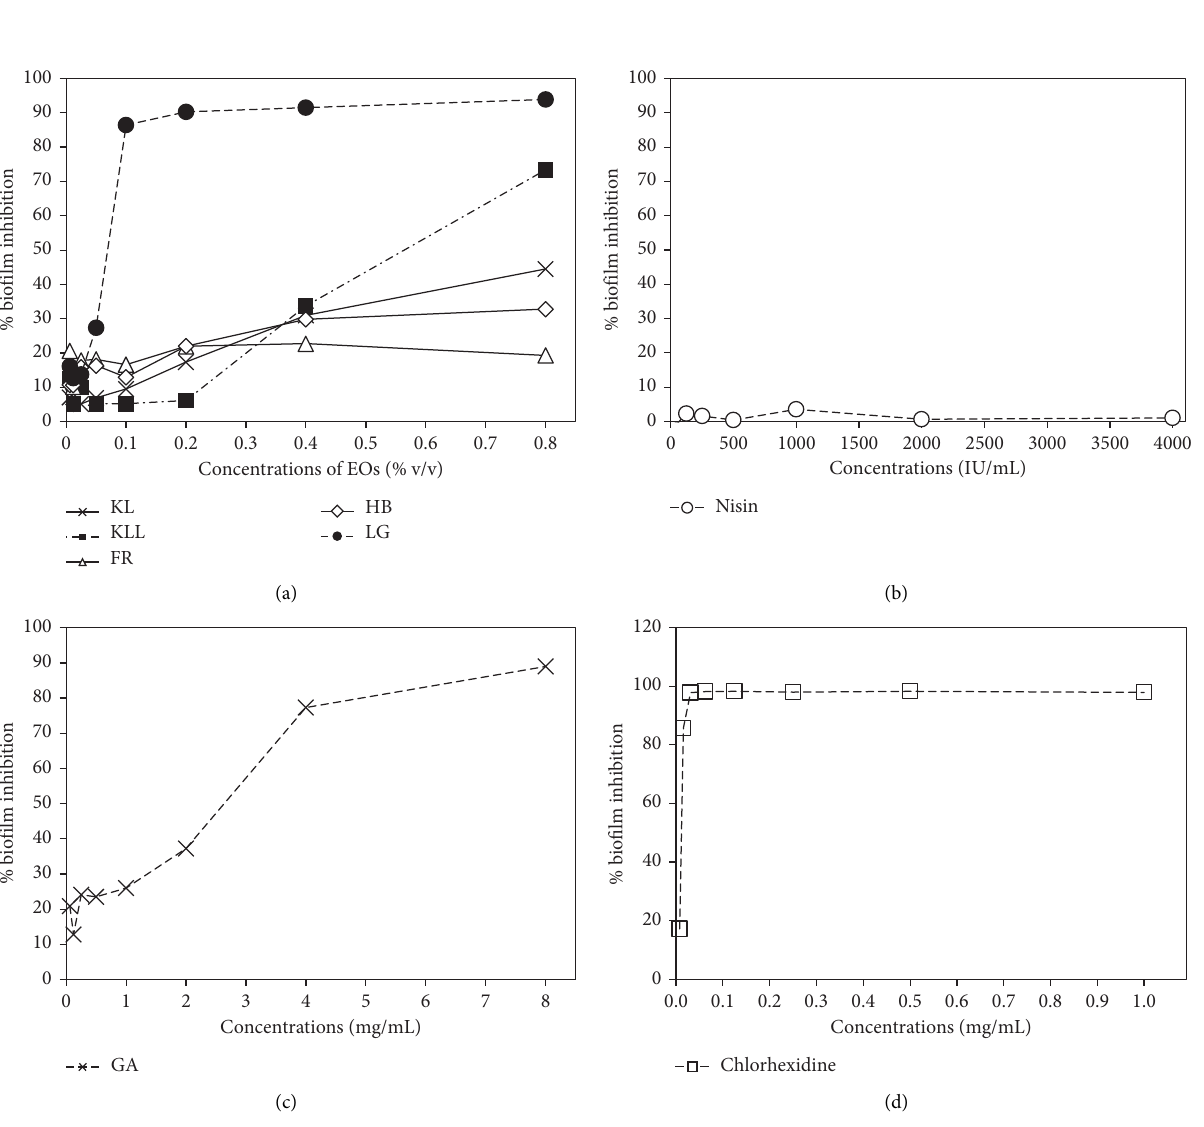
Figure 1: The inhibition effects of five EOs (a), nisin (b), GA (c), and chlorhexidine (d) on biofilm formation of S. mutans ATCC